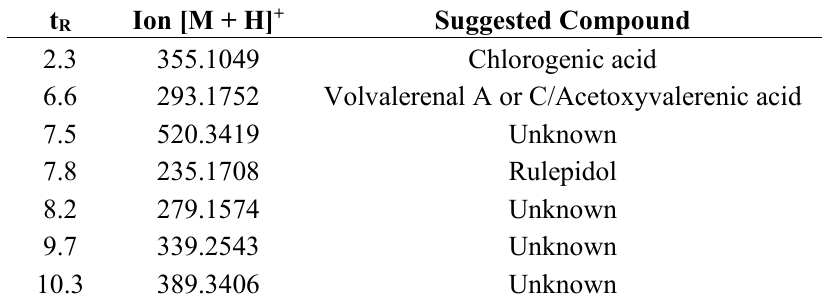
Figure A3. ID_26. Extract of Valeriana officinalis L . Table A5. Dereplication results for